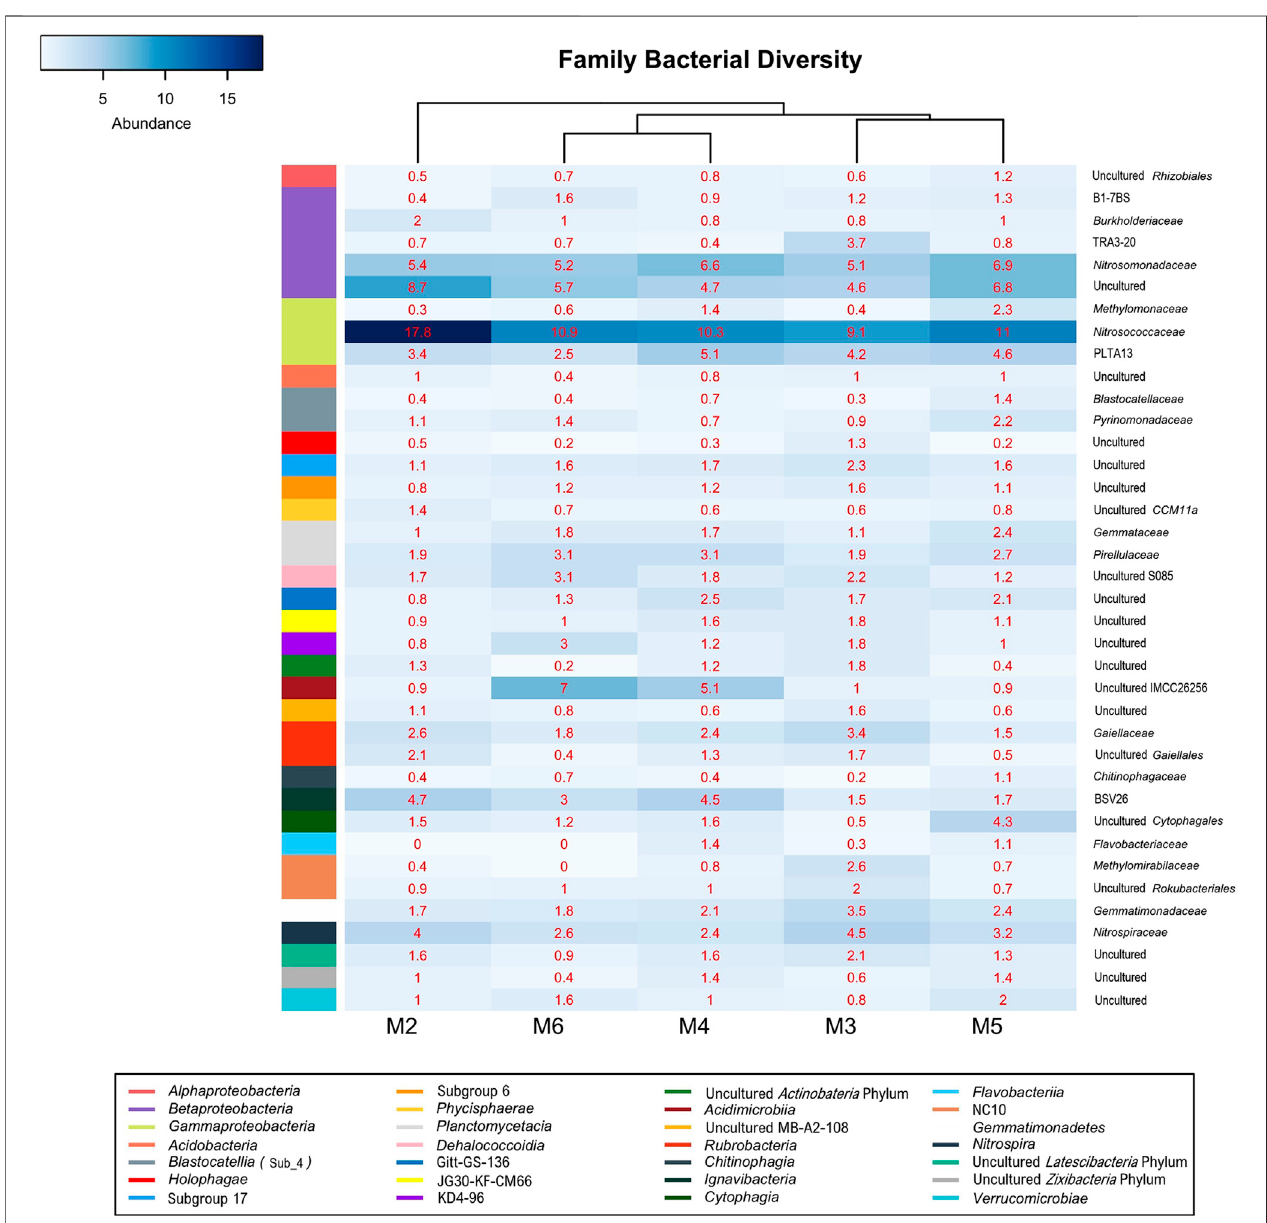
FIGURE7| Heat-mapanalysisofMorganaCavebacterialcommunityrelativeabundanceatfamilylevel.Theidenti fi edgroupsarepresentedintherightcolumnand their class level indicated in left-colors column.